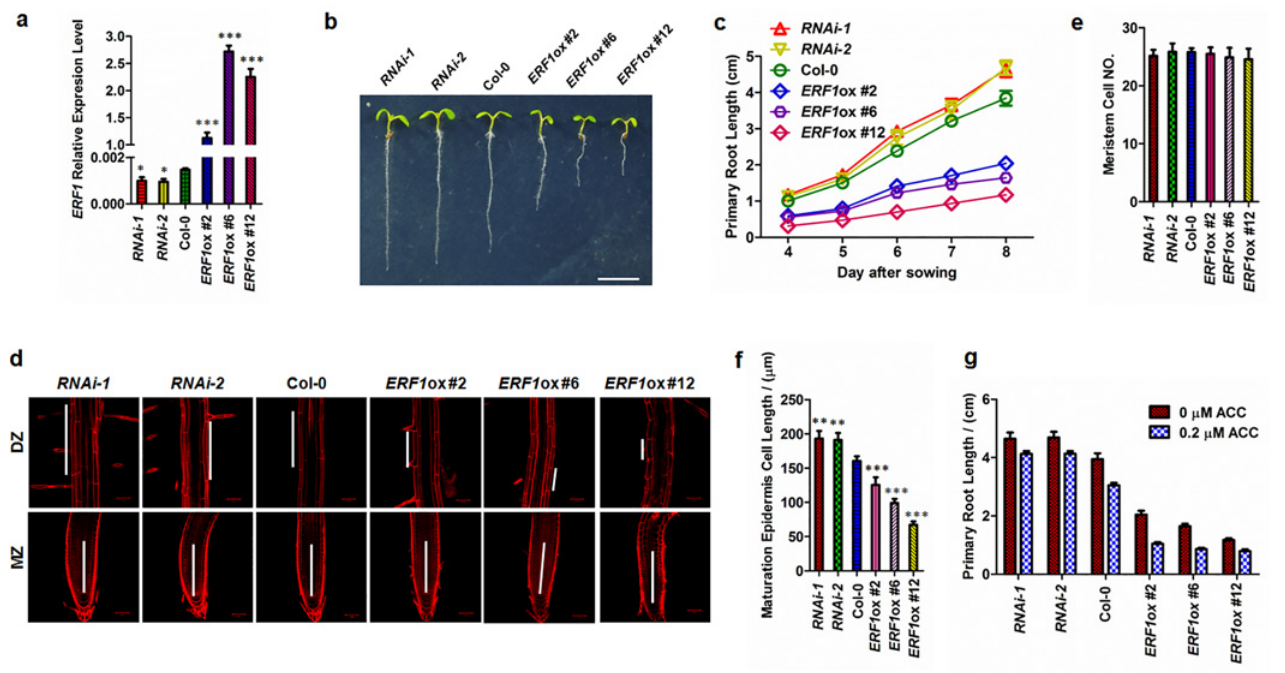
Fig 2. Role of ERF1 in ethylene-mediated inhibition of primary root elongation. ( a-c ) Primary root phenotypes of ERF1 knockdown ( RNAi-1 , RNAi-2 ) and overexpression ( ERF1ox #2 , ERF1ox #6 , ERF1ox #12 ) transgenic lines. The expression level of ERF1 in 5 day-old-seedlings was tested by qRT-PCR ( a ). Values are mean ± SD of three replicas ( * P < 0.05, *** P < 0.001). Asterisks indicate Student ’ s t-test significant differences. The representative seedlings were photographed ( b ). Scale bar, 1 cm. The primary root length of these related transgenic lines and Col-0 was measured from 4 to 8 d ( c ). Data shown are average and SD (Values are mean ± SD, n = 20). ( d-f ) Epidermal cell length within the DZ was affected in ERF1 knockdown ( RNAi-1 , RNAi-2 ) and overexpression ( ERF1ox #2 , ERF1ox #6 , ERF1ox #12 ) transgenic lines. The primary root MZ and DZ of the 5-day-old seedlings of indicated lines were photographed. Representative images are shown ( d ). Root meristem cell number ( e ) and epidermal cell length of the maturation zone ( f ) were measured. The root meristem cell number was counted from the QC to the first elongation cell in the cortex file. The mean ± SD (n = 20) is shown, ** P < 0.01, *** P < 0.001). Asterisks indicate Student ’ s t-test significant differences. ( g ) Primary root length of ERF1 knockdown ( RNAi-1 , RNAi-2 ) and overexpression lines grown on medium with or without ACC treatment. Five-day-old seedlings grown on MS medium were transferred to MS medium containing 0 or 0.2 μ M ACC and growth vertically for 3 d. The mean ± SD is shown (n =